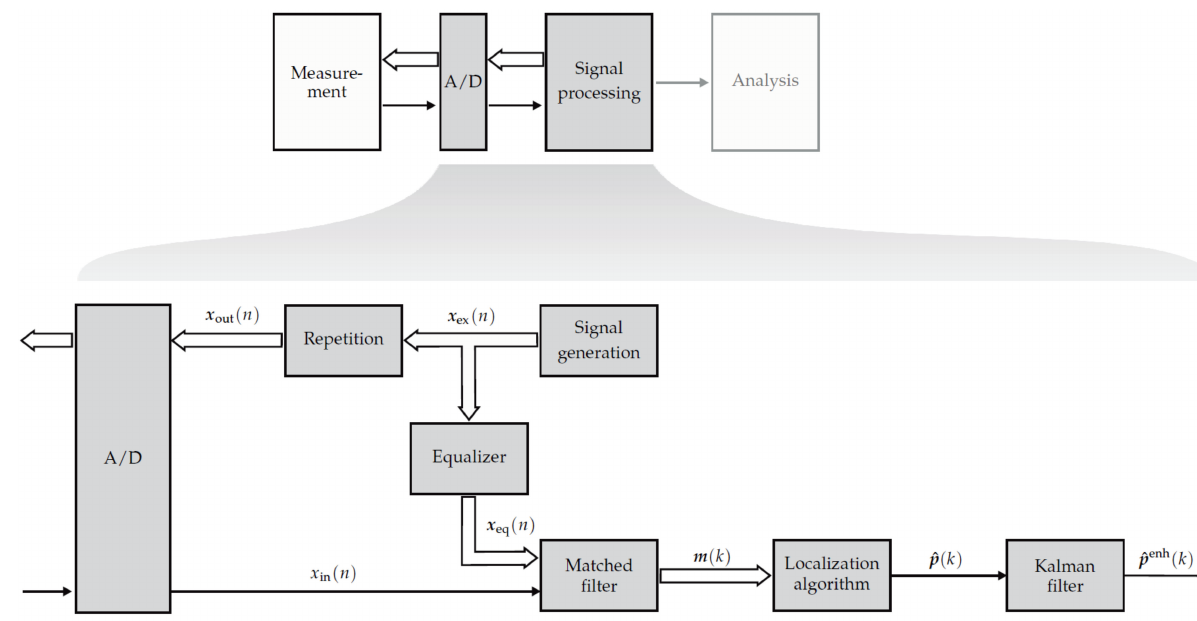
Figure 5. Processing chain for the localization of magnetoelectric sensors in real time. The input signal of the sensor is matched filtered with the equalized coil signals. The matched filter outputs at time lag zero are compared with the lead-field matrix entries. A first order Kalman filter smooths the estimated position-orientation-pairs over time to mitigate possible